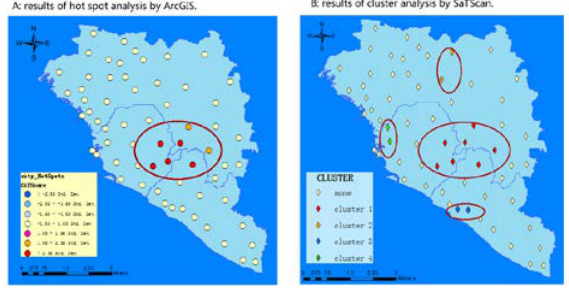
Figure 4. Spatial clusters of global EVD from March to June 2014